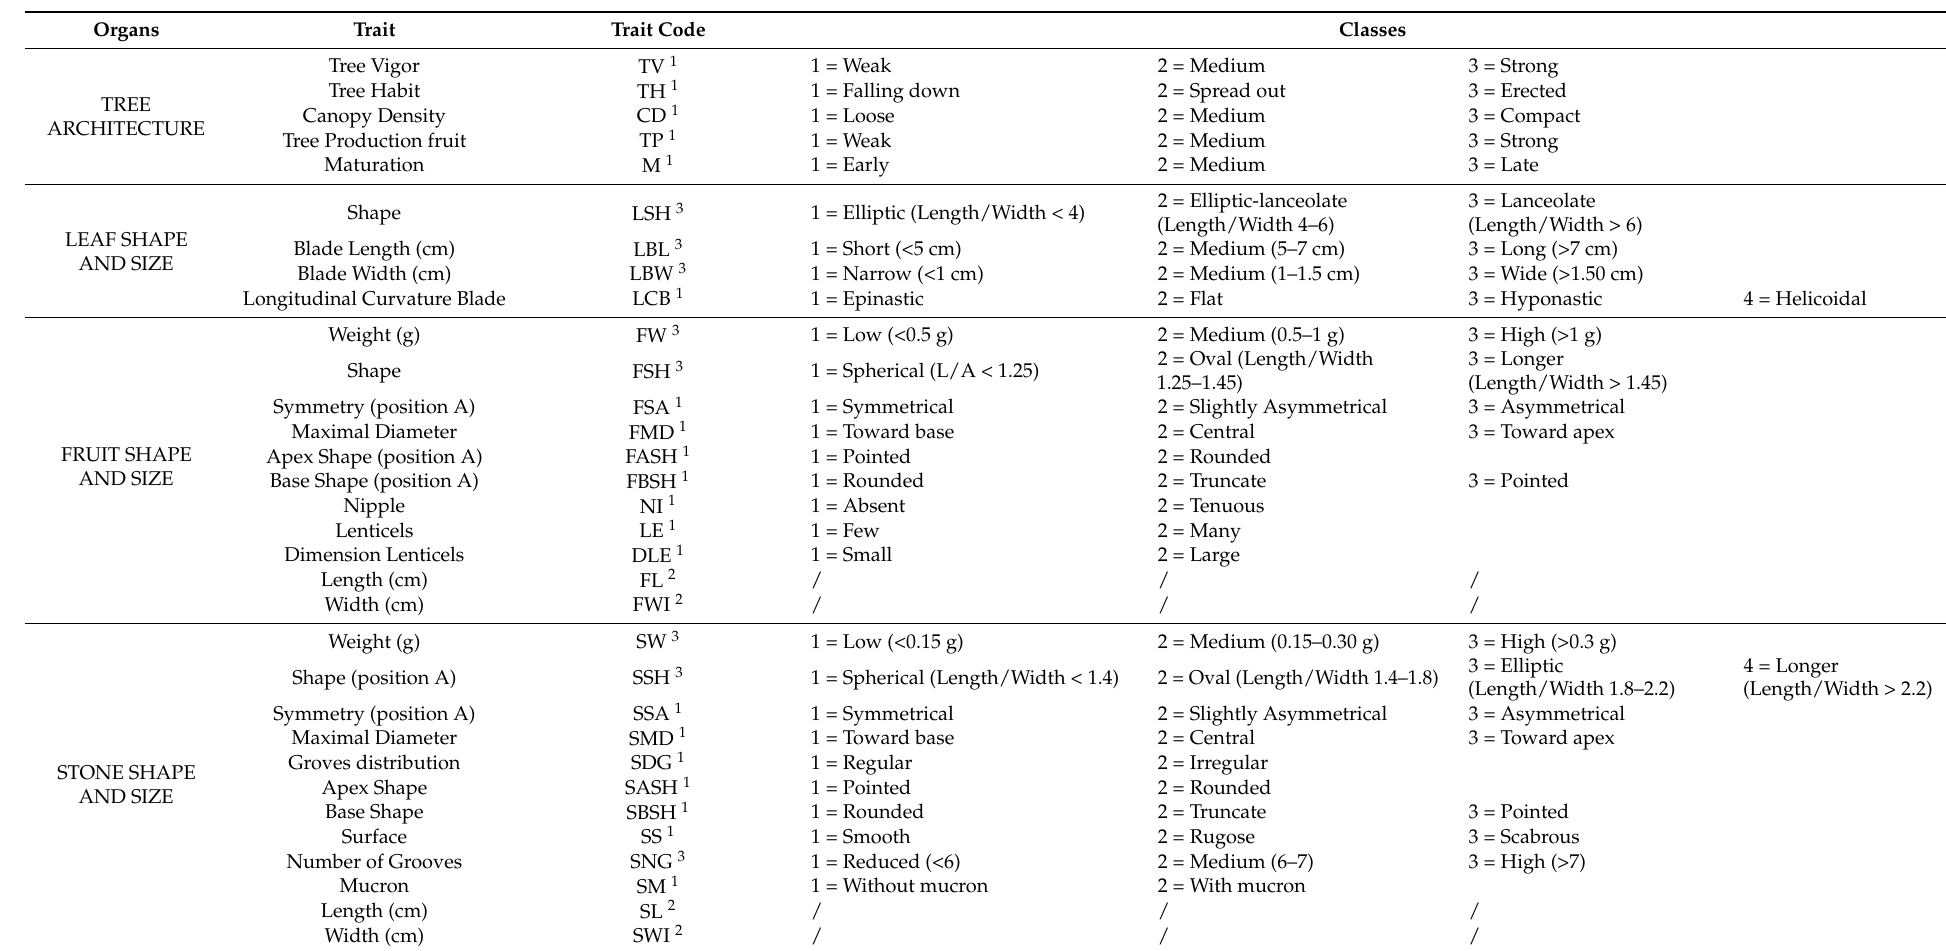
Table 1. Qualitative and quantitative descriptors were used for the characterization of Algerian wild olive samples, following the UPOV methodology. Eight traits were considered as both quantitative and qualitative